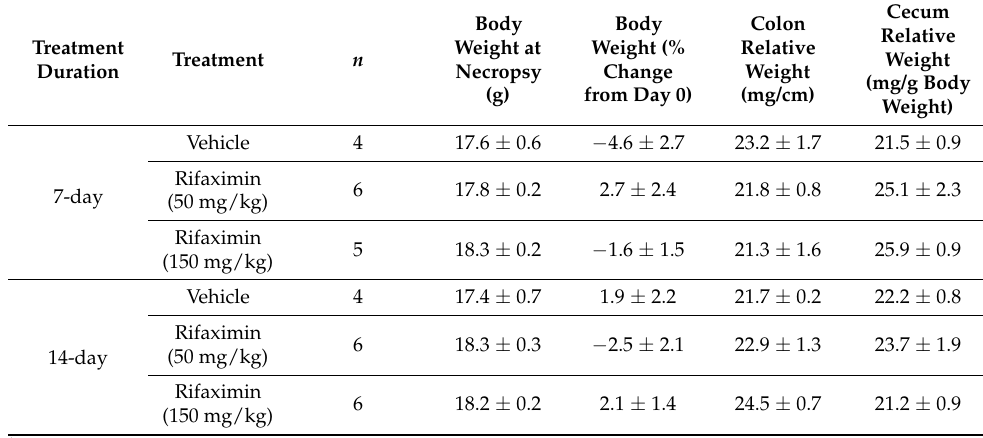
Table 1. Body weight and relative weight of colon and cecum in the different experimental groups 1